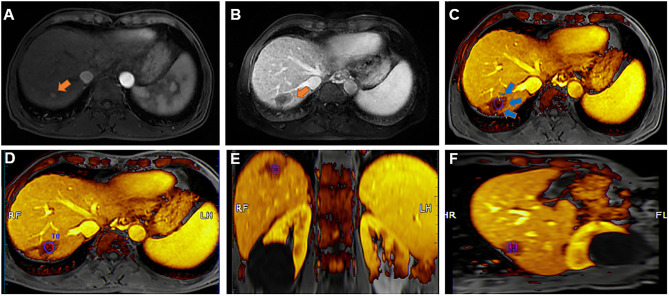
An example of margin assessment based on MR-MR fusion. (A) Co-registered pre-ablation MR images show the tumor zone (orange arrow); (B) Co-registered post-ablation MR images show the ablation zone (orange arrow). (C) Achievement of registration between the tumor and ablation zones (blue arrow). (D–F). Segmented tumor (red) and theoretical 5 mm (blue) margin contours overlaid on the ablation zone on the axial, sagittal, and coronal MR images.